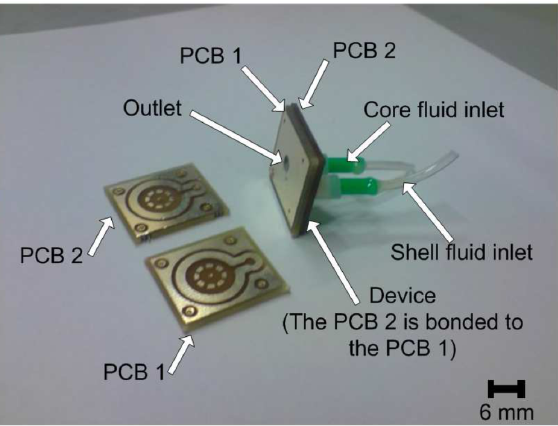
Figure 20. Photograph of the flow-focusing device obtained after the manufacturing process (copy- right (2011) IEEE. Reprinted, with permission, from